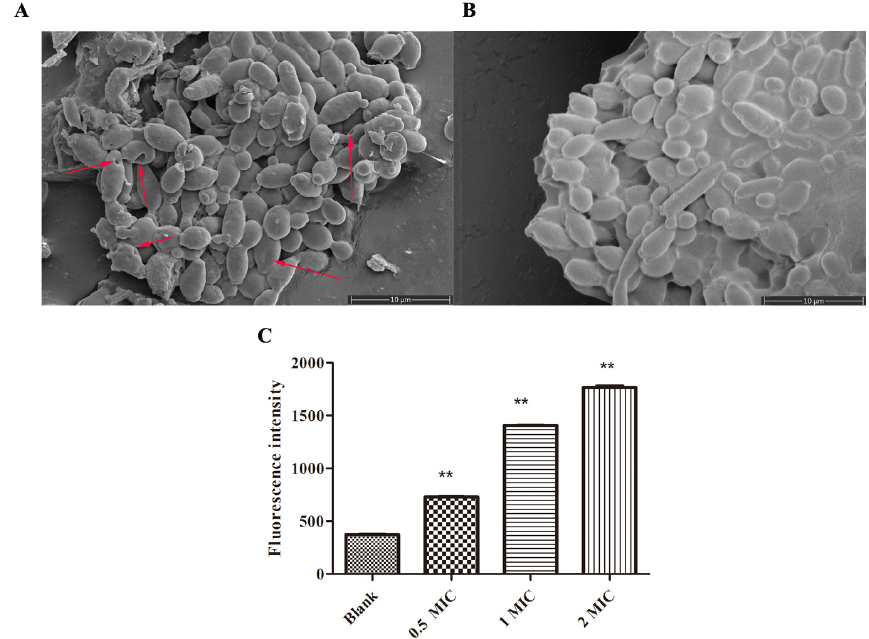
Figure 3. Antifungal mechanism of NpRS. ( A ) Scanning electron microscope image of C. albicans under the treatment of NpRS (1×MIC) after 3 h of incubation; ( B ) Scanning electron microscope image of C. albicans under the treatment of blank control after 3 h of incubation; ( C ) Effects of NpRS on the membrane potentials of C. albicans after 30 min of incubation. All data were expressed as the mean values of triplicate ± standard deviation. ** p < 0.01, compared with blank control.